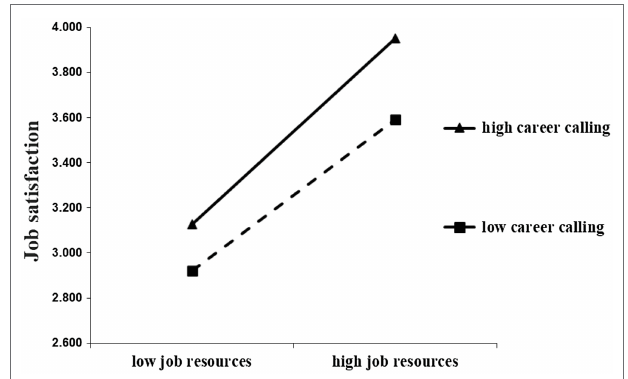
FIGURE 3 | Moderating effect of career calling in the relation between job resources and job satisfaction.